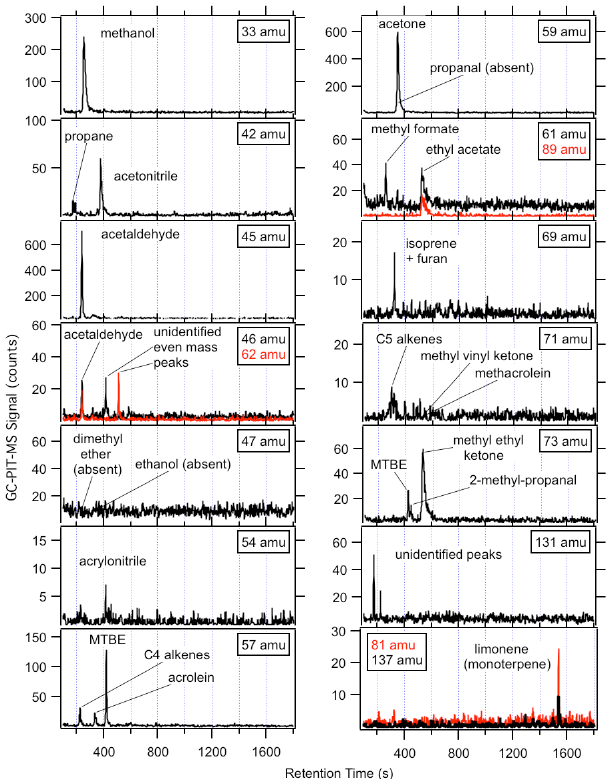
Fig. 3. Select GC-PIT-MS chromatograms obtained during the MI- LAGRO campaign. Signals reported are sums of six individual chromatograms. The retention time scale is slightly adjusted to be comparable with previously reported values for GC-PTR-MS using the same GC instrument and temperature program (Warneke et al., 2003).